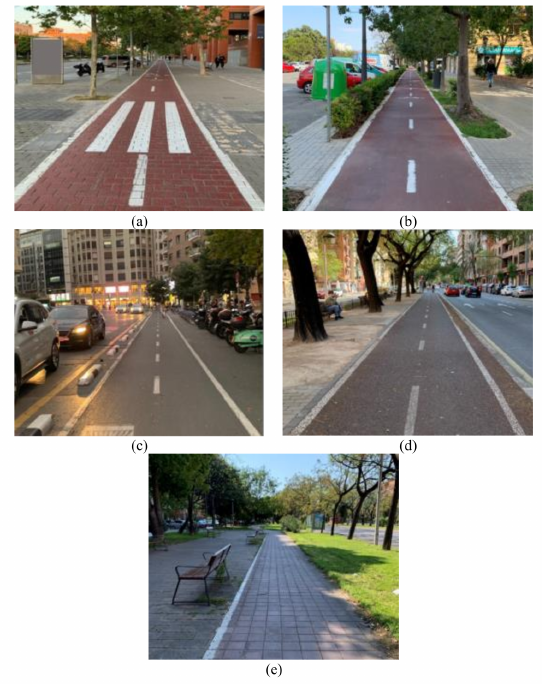
Figure 1. Typologies of bicycle tracks: ( a ) sidepath without physical or vegetated curb, ( b ) sidepath with vegetated curb, ( c ) protected bicycle track, ( d ) sidepath on median next to motorised traffic, and (e) sidepath on